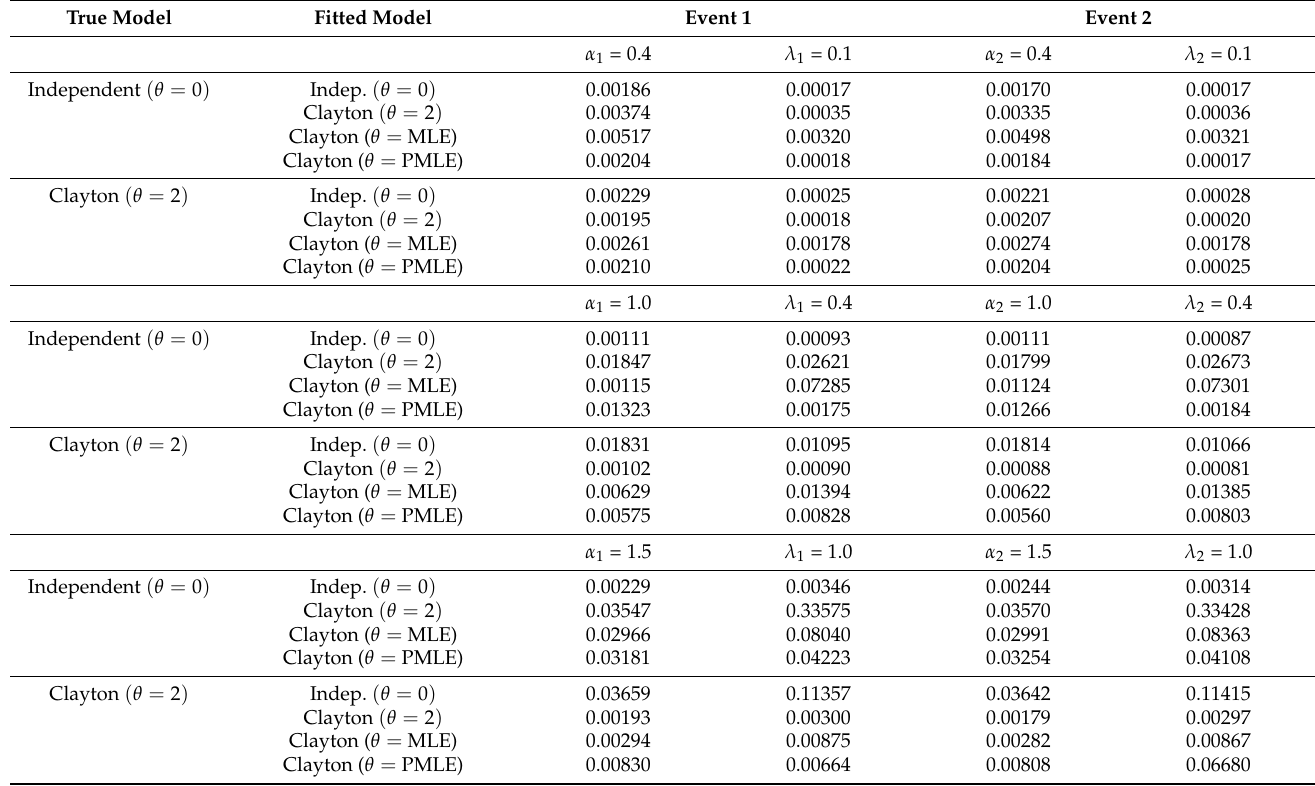
Table 2. The MSEs of parameter estimates based on 1000 simulation